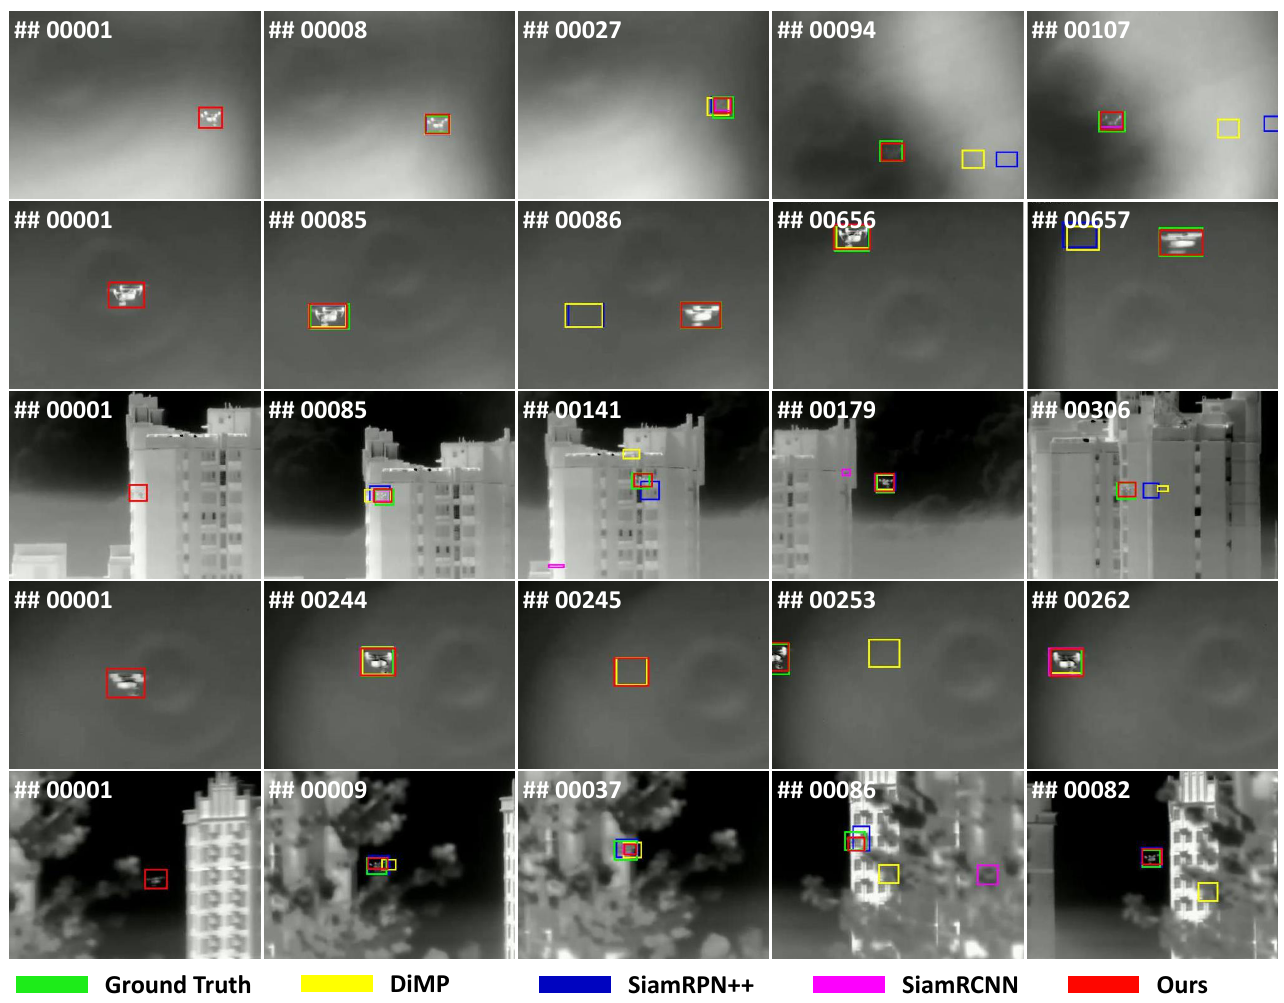
Figure 6. Qualitative comparison of SiamSTA with other state-of-the-art trackers in handling different challenging scenarios. From top to bottom are Motion Blur (Sequence 20190925_222534_1_7_1), Fast Motion (Sequence 20190925_210802_1_3_1), Thermal Crossover ( Sequence 20190925_133630_1_9_1), Out-of-view ( Sequence 20190925_210802_1_8_1) and Occlusion (Sequence